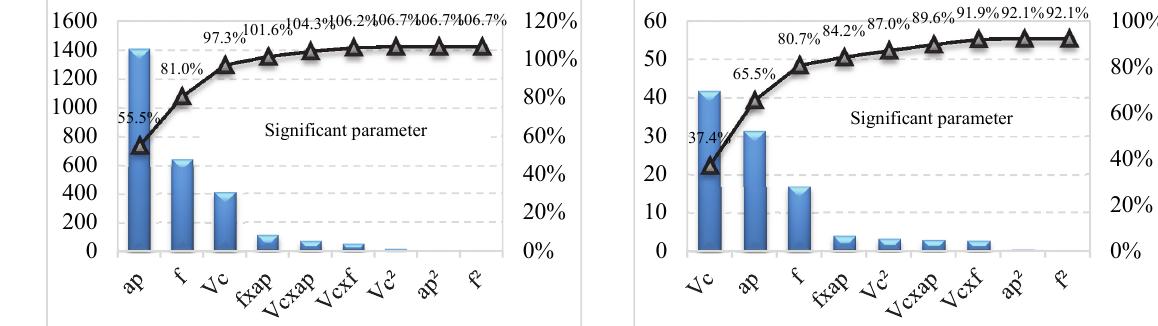
Fig. 6. Pareto chart of the standardized effects on material removal rate Fig. 7. Pareto chart of the standardized effects on cutting power ( α = 0,05) ( α =0,05)